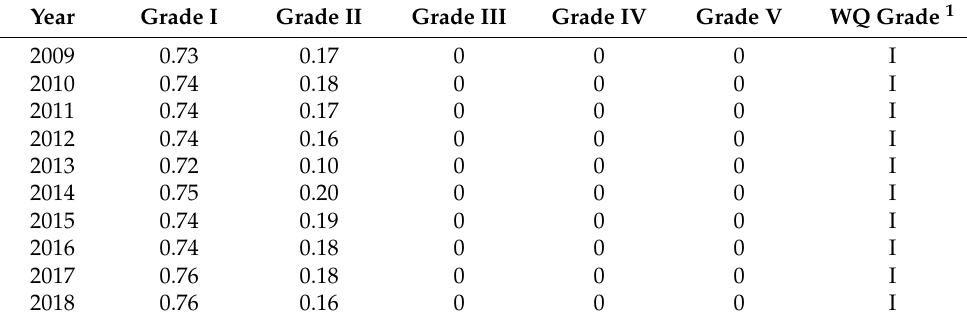
Table A10. Fuzzy integrated evaluation results of Shazhu Station in Wuxi,